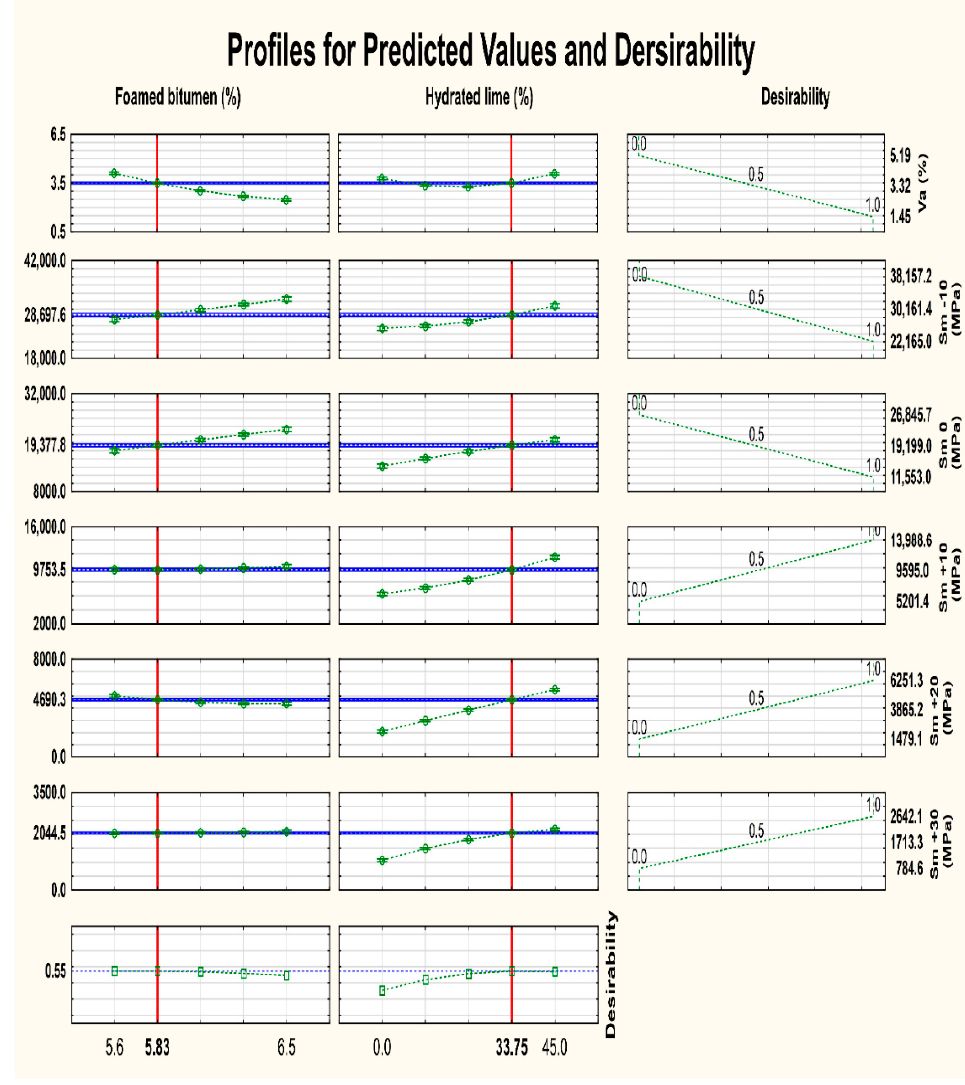
Figure 10. Profiles of approximated values and desirability function for the recommended amount of foamed bitumen and hydrated lime in asphalt concrete AC 8 S. foamed bitumen and hydrated lime in asphalt concrete AC 8 S. Materials 2020 , 13 , x FOR PEER REVIEW